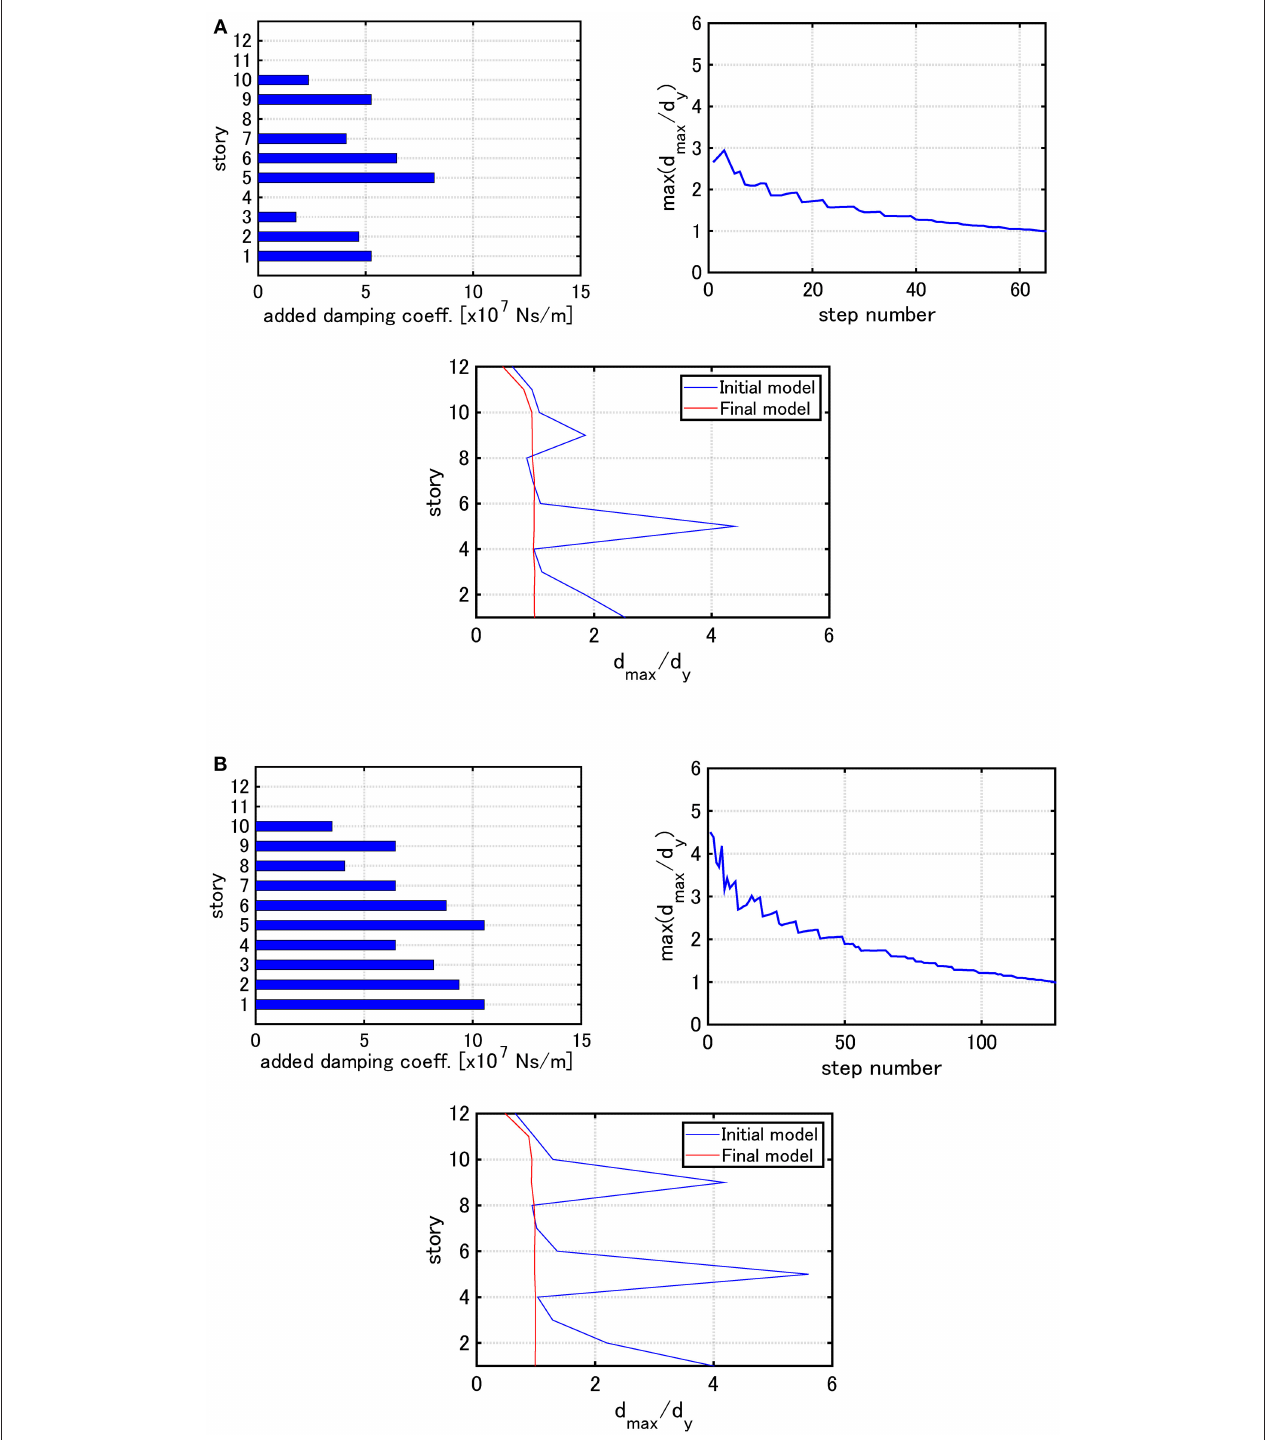
FIGURE 8 | Distribution of added damping coefficients, max ( d max , i / d y ) with respect to step number and the distribution of d max , i / d y under the critical double impulse for Model 3 (Problem 1): (A) V = 0.84[m/s], (B) V = 1.23[m/s].